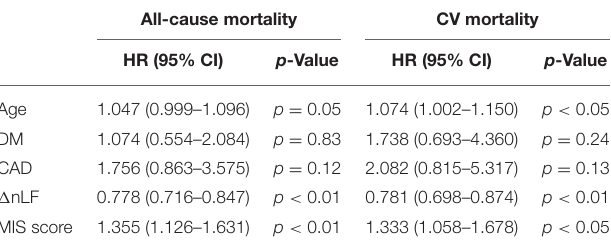
TABLE 5 | Multivariate Cox regression analysis of key prognostic factors for all-cause and CV mortality. All-cause mortality